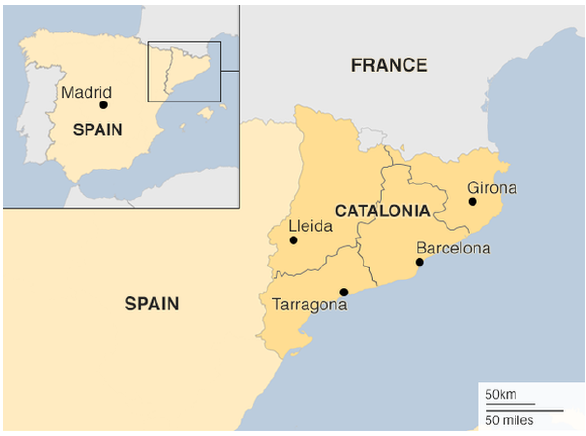
Figure 1. Geographical map of Catalonia,